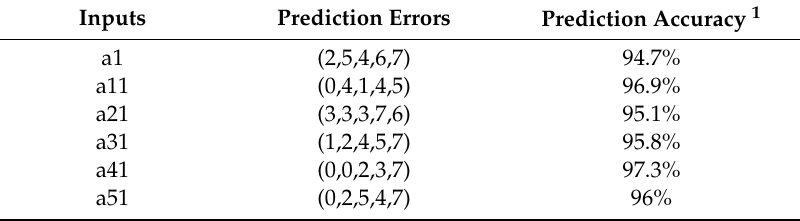
Table 7. Testing results based on the incomplete dataset.